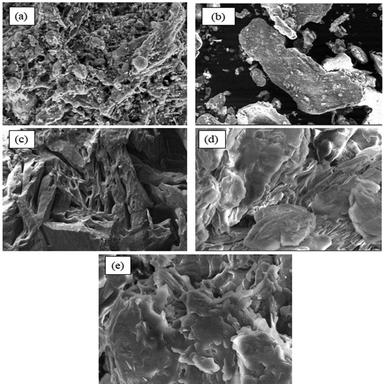
Comparison of surface morphology at 5000X magnification of (a) carbon BC, (b) recycled Al powder, (c) stearic acid, (d) 15 wt% Al/SA, (e) 15 wt% BC/SA.